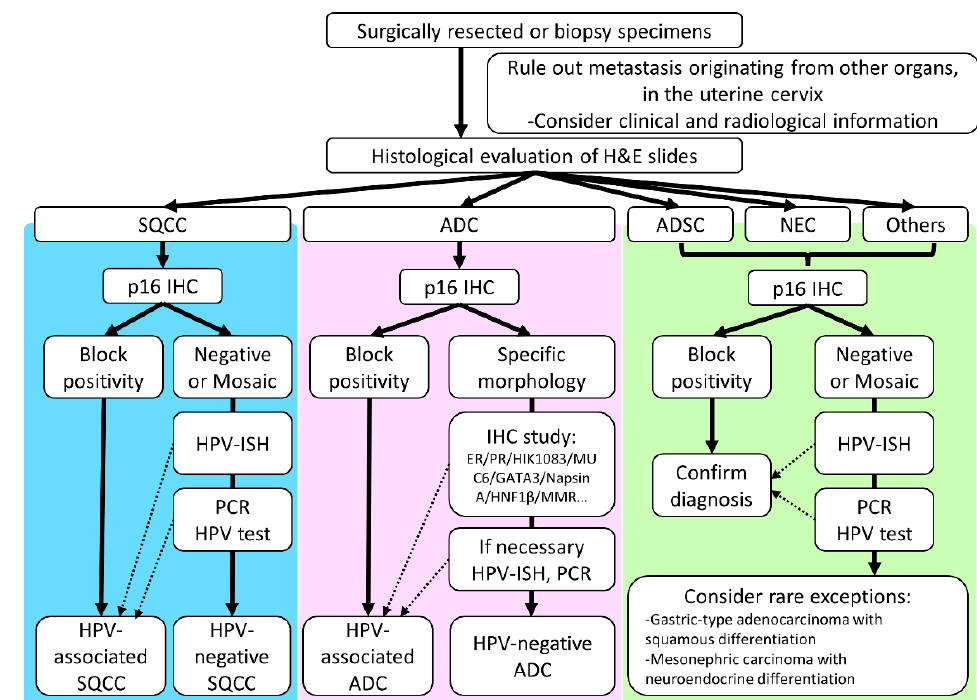
Figure 2. Histological typing of invasive cervical cancer. A thorough examination of clinical and radiological data, as well as H&E-stained slides, is essential. Ancillary tests such as p16 immuno- histochemistry, HPV in situ hybridization, or PCR-based HPV testing should be used for